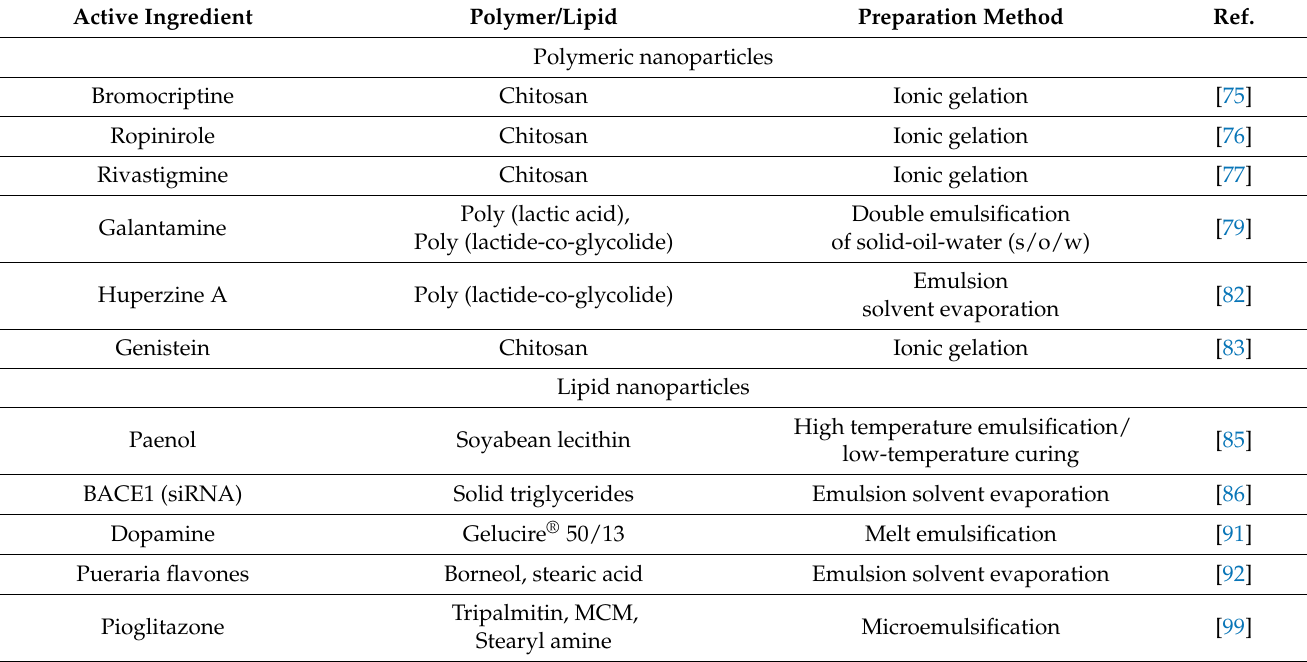
Table 2. Polymeric and lipid nanoparticles developed for nose-to-brain delivery in the treatment of NDs.